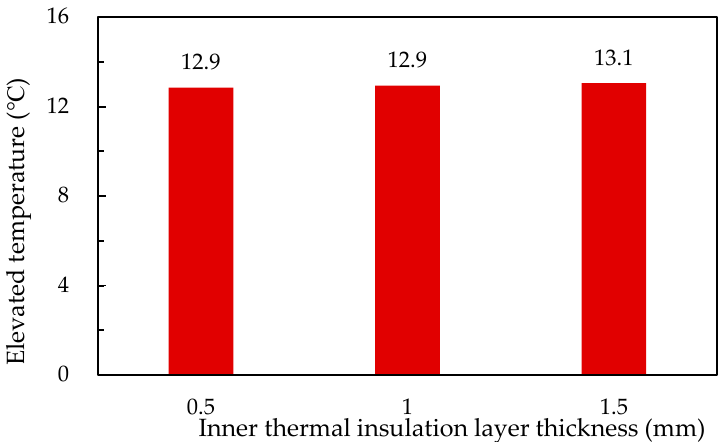
Figure 11. Effects of inner thermal insulation layer thickness on wax layer temperature increment (original wax layer temperature is 20 °C; magnetic field frequency is 500 kHz; the electrical current intensity is 20 A; SPM-NP diameter is 18 nm; pig velocity is 0.4 m/s; the flow rate is 0.4 m/s; induc- tion coil turn number is 310 turns; nanoparticle content is 10%).